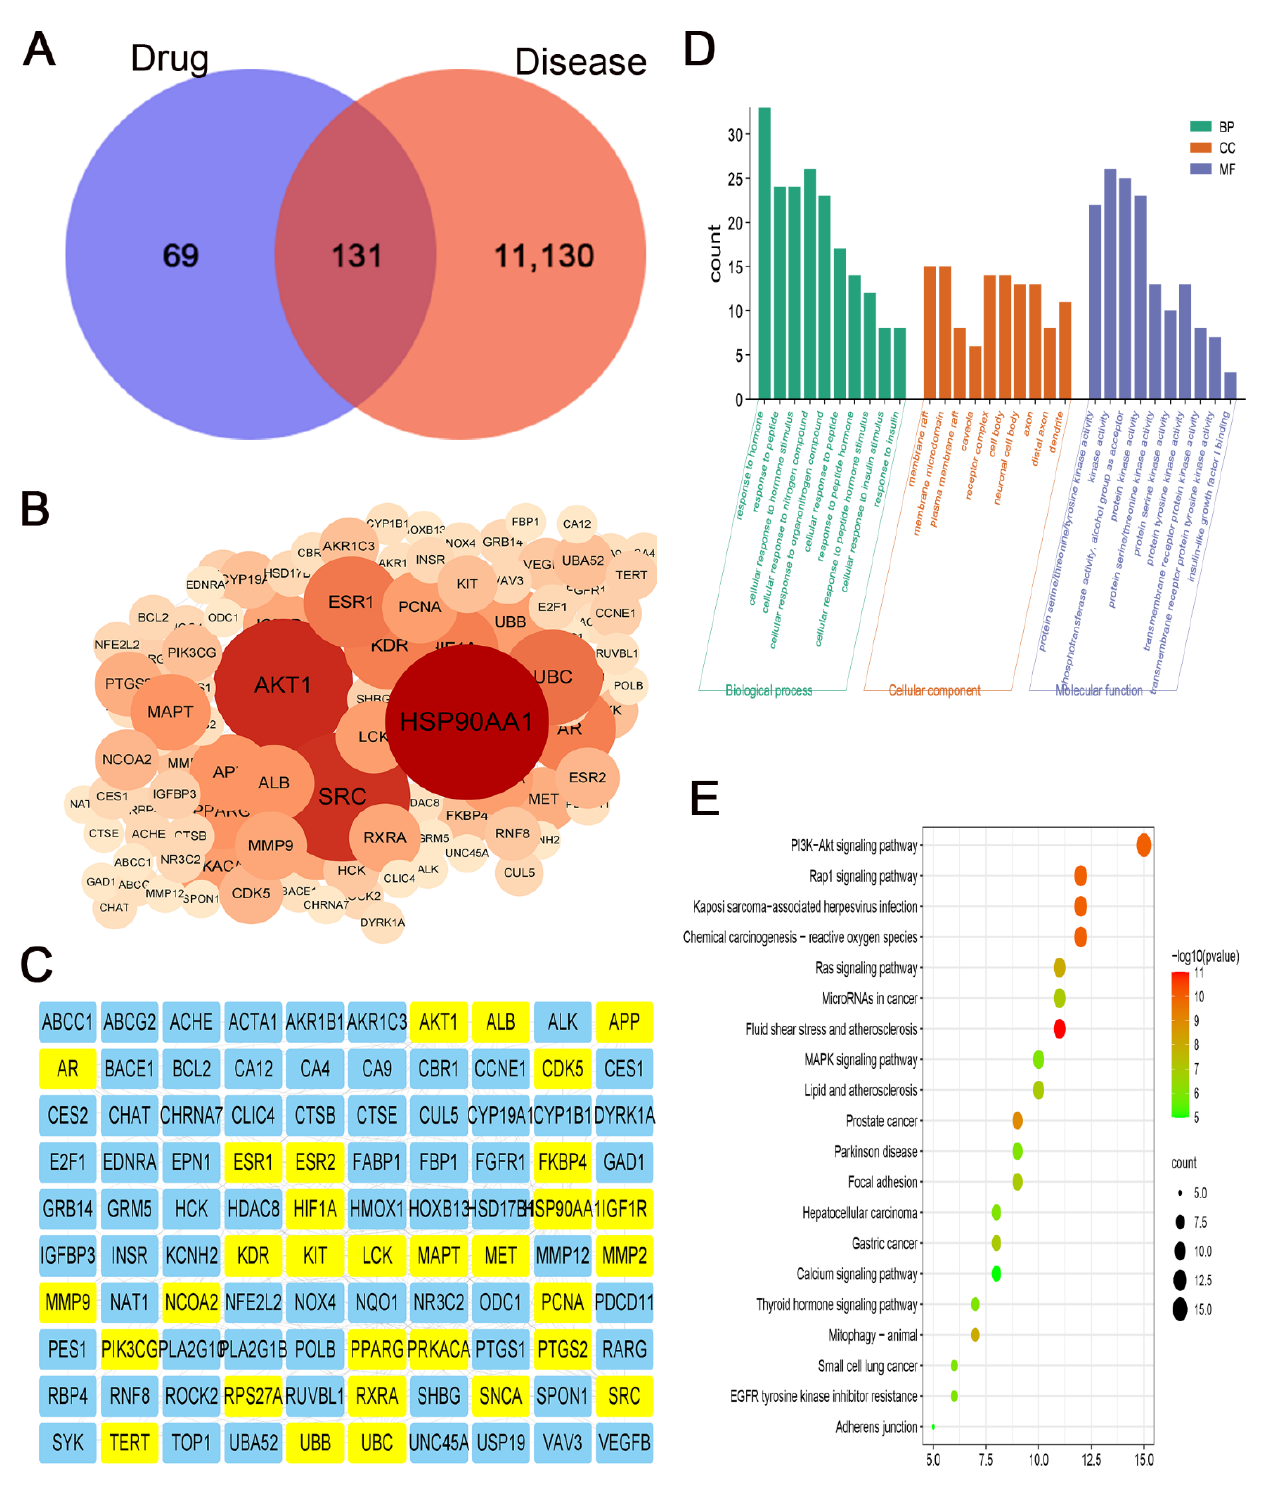
Figure 5. Network pharmacology analysis of the candidate targets of eriodictyol against GC. ( A ) Venn diagram revealing the overlapping potential targets between eriodictyol treatment and GC. ( B ) The result of PPI analysis for overlapping potential targets. ( C ) 100 core targets of eriodictyol acting on GC. ( D ) The result of GO enrichment analysis for the potential pathways of eriodictyol in GC. ( E ) The result of KEGG enrichment analysis for the potential pathways of eriodictyol in GC.